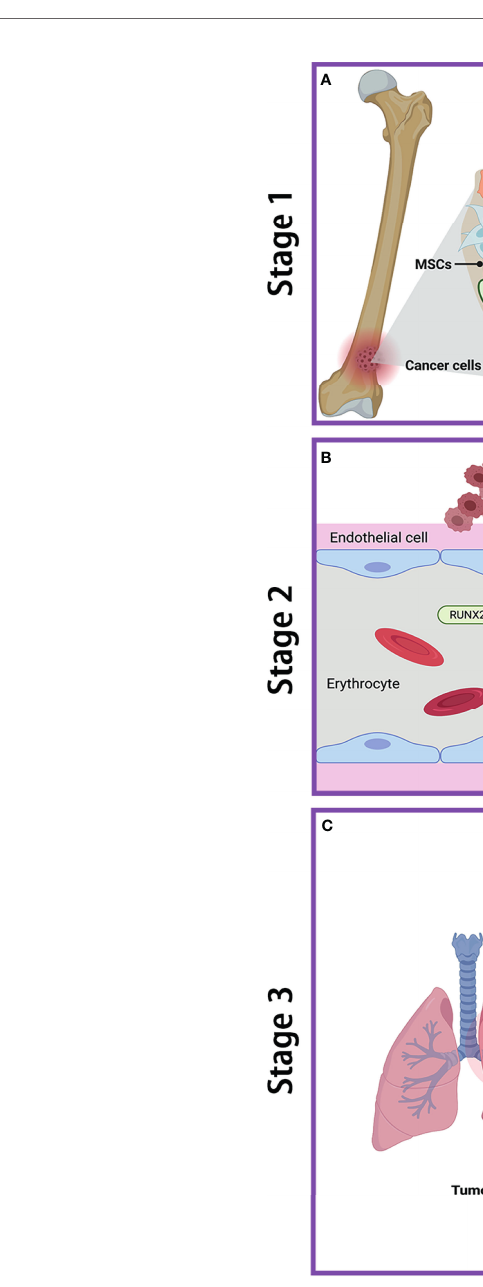
FIGURE 1 | Metastatic cascade of OS to the lung. (A) Stage 1: dissemination of metastatic OS cells from primary site. Cancer cells induce OB to secrete RNAKL, which binds to OC, and lead to bone resorption. The increase of MMPs and cathepsins while decrease of TIMPs cause ECM degradation. Cancer cells secret SDF- 1 to recruit MSCs, which in turn promote tumor growth and metastasis by secreting CCL-5. NK cells kill cancer cell through the interaction between NKG2D receptor and NKG2D ligands (NKG2DL). (B) Stage 2: transfer of OS cells in blood. The interaction between uPAR and FPR1 enhances invasion of cancer cell and their entry into blood. RUNX2/OPN axis promotes adhesion of cancer cell to endothelia cell in lung. FASN and ID1 increase anoikis resistance in cancer cell by upregulating p-ERK1/2 and Bcl-xL and by activating PI3K/AKT pathway, respectively. (C) Stage 3: colonization of OS cells in lung. The ER stress-initiated UPR protects cancer cell from apoptosis by activating GRP78 and ATF6, as well as through NF- k B pathway. The mechanical restriction of circulating cancer cells within lung microvasculature partly accounts for the propensity of lung metastasis. Tumor-secreted vesicles reach the lung in advance and direct cancer cell to transfer to the lung. OS, osteosarcoma; OB, osteoblast; OC, osteoclast; RANK, receptor activator of NF- k B; RANKL, receptor activator of NF- k B ligand; MMPs, matrix metalloproteinases; TIMPs, tissue inhibitor of metalloproteinases; ECM, extracellular matrix; SDF-1, stromal cell-derived factor-1; MSCs, mesenchymal stem cells; CCL-5, C – C motif chemokine ligand 5; NKG2D, natural killer group 2 member D; uPAR, urokinase-type plasminogen activator; FPR1, formyl peptide receptor type 1; RUNX2, runt ‐ related transcription factor 2; OPN, osteopontin; FASN, fatty acid synthase; ID1, inhibitor of differentiation or DNA binding; ERK, extracellular signal- regulated kinase; Bcl-xL, B-cell lymphoma-extra large; ER, endoplasmic reticulum; UPR, unfolded protein response; GRP78, glucose-regulated protein 78KD; ATF6, activating transcription factor 6; IT-139, a novel small molecule that inhibit